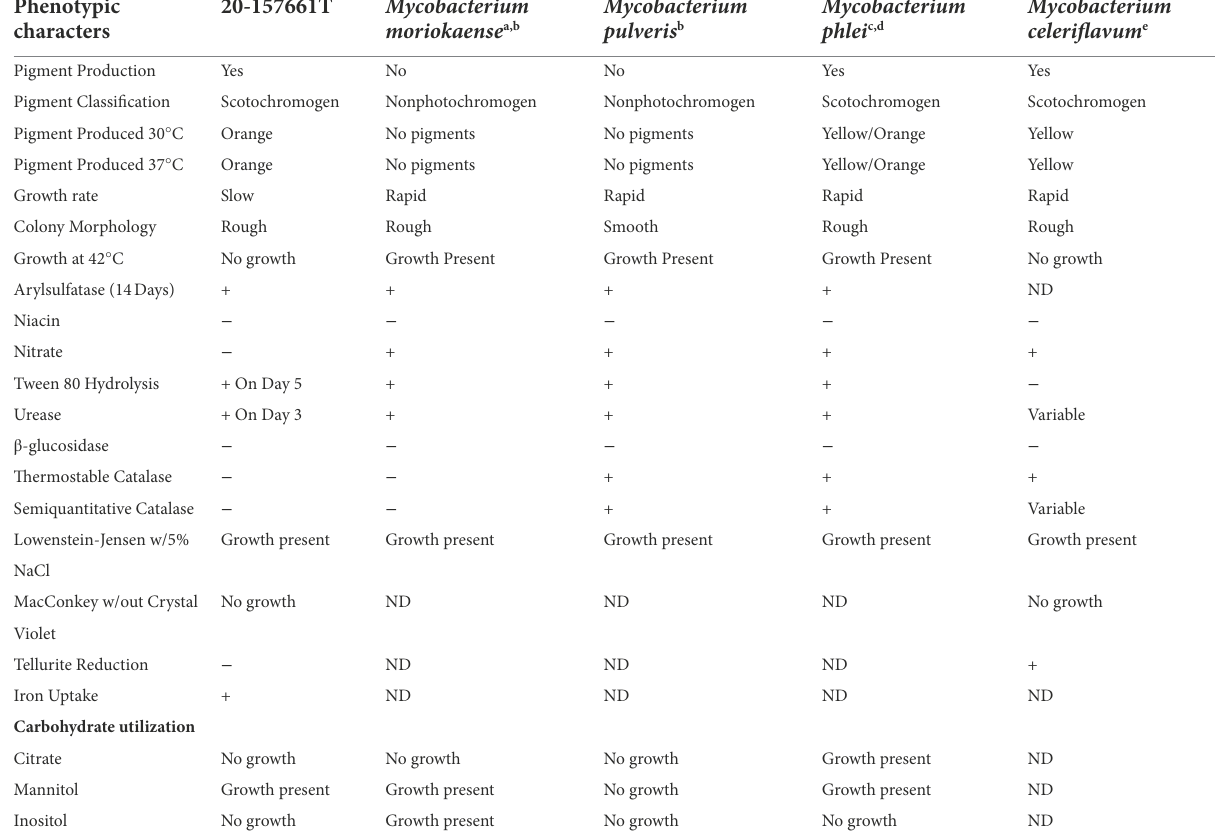
TABLE 1 Phenotypic characteristics of strain 20-157661T.